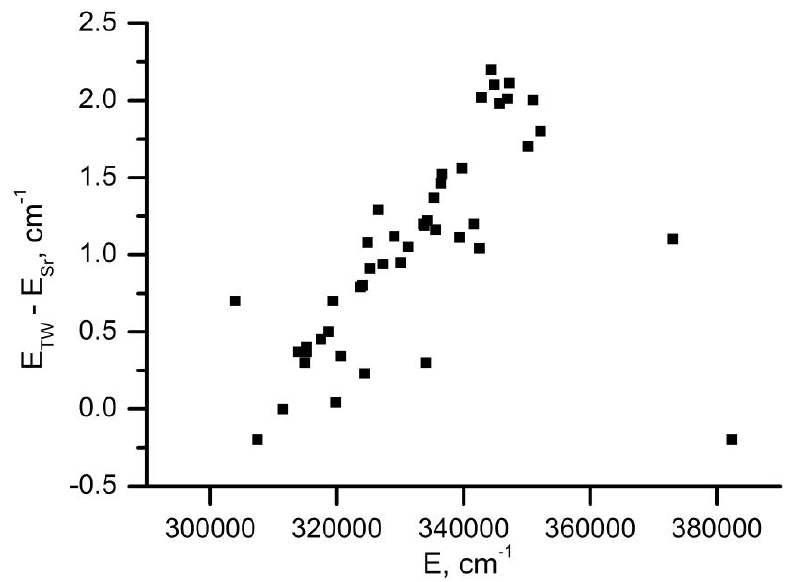
Figure 1. Difference between the level energies of the 4d 8 5p configuration measured in this work (E TW ) and the energies E Sr published by Srivastava at al. [2].